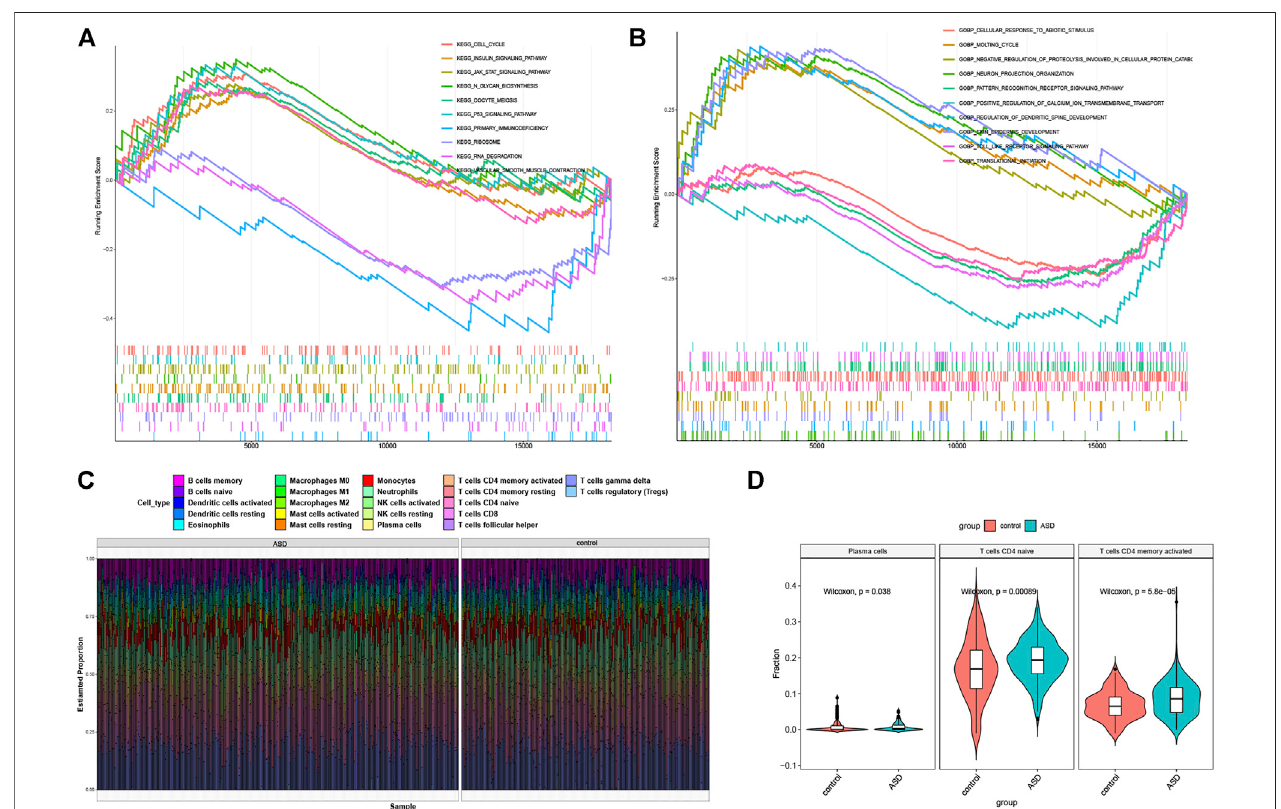
FIGURE 3 | Functional enrichment and immune in fi ltration analysis between healthy controls and ASD children. (A and B) GSEA enrichment analysis showing signi fi cantly activated pathways (A) and biological functions (B) in ASD patients. (C) Representative barplot of the relative proportion of 22 in fi ltrated immune cells in control and ASD samples. (D) Box plots showing the heterogeneity of in fi ltrated immune cells between control and